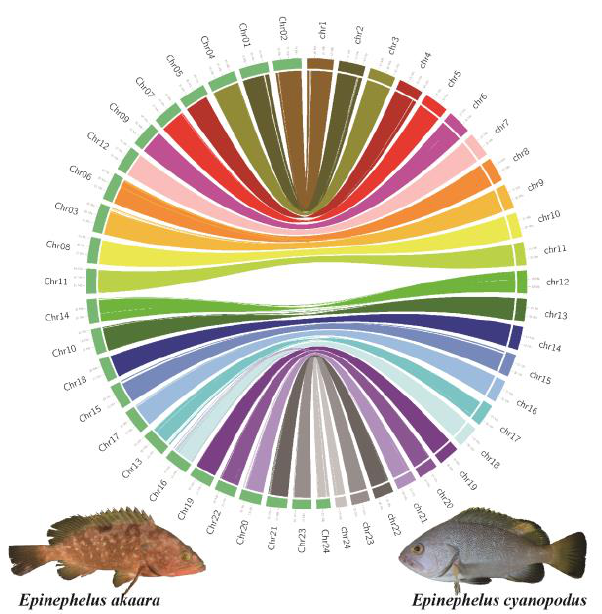
Figure 2. Genomic synteny analysis between E. cyanopodus and E. akaara . Each colored arc depicts inter-chromosomal synteny.